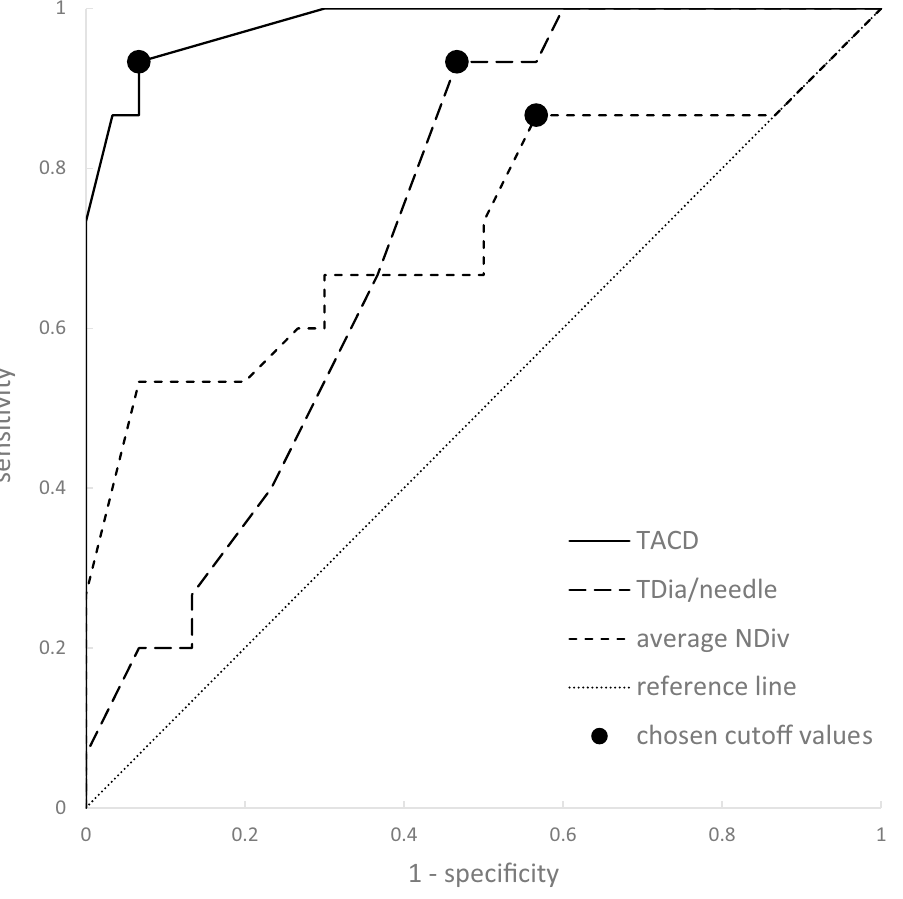
Figure 6. ROC curve analysis calculated for TACD, TDia/needle, and NDiv to determine cutoff values. Chosen cutoff values are indicated as black